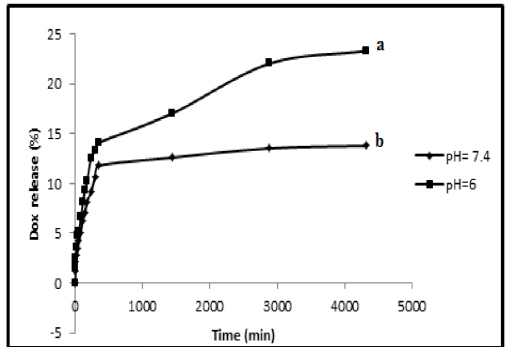
Fig. 5. Release profiles of DOX from nanocarrier in PBS at 37˚C (a) pH=7.4, (b) pH=6.0.